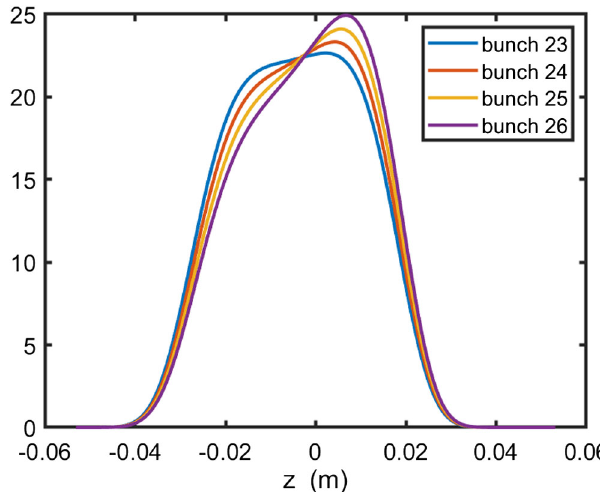
FIG. 12. The four guard bunches at the beginning of a train of 26, each with ξ ¼ 1 . 5 . These lean